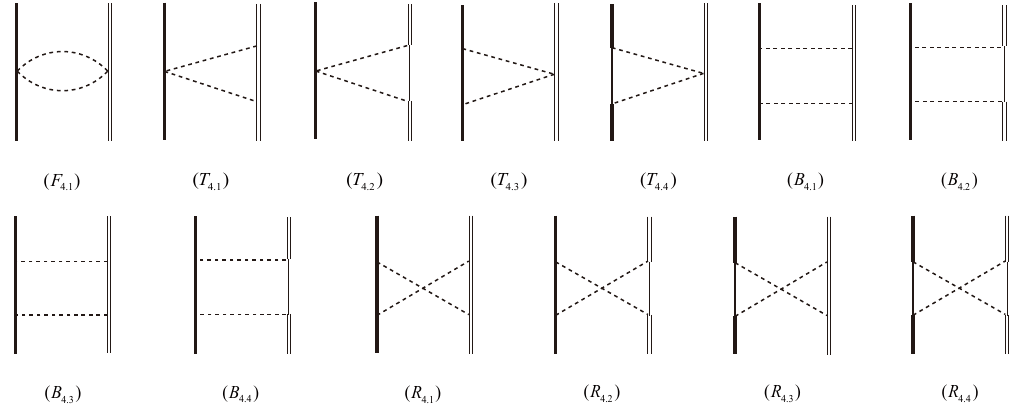
(cid:22) D (cid:3) system at O ( (cid:15) 2 ). The internal heavy c